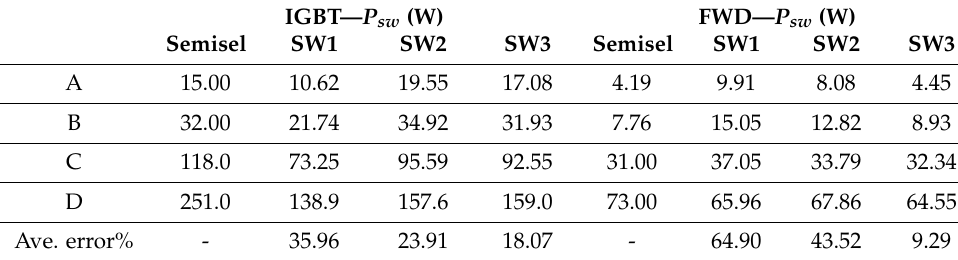
Table 10. Switching losses comparison, V DC = 700